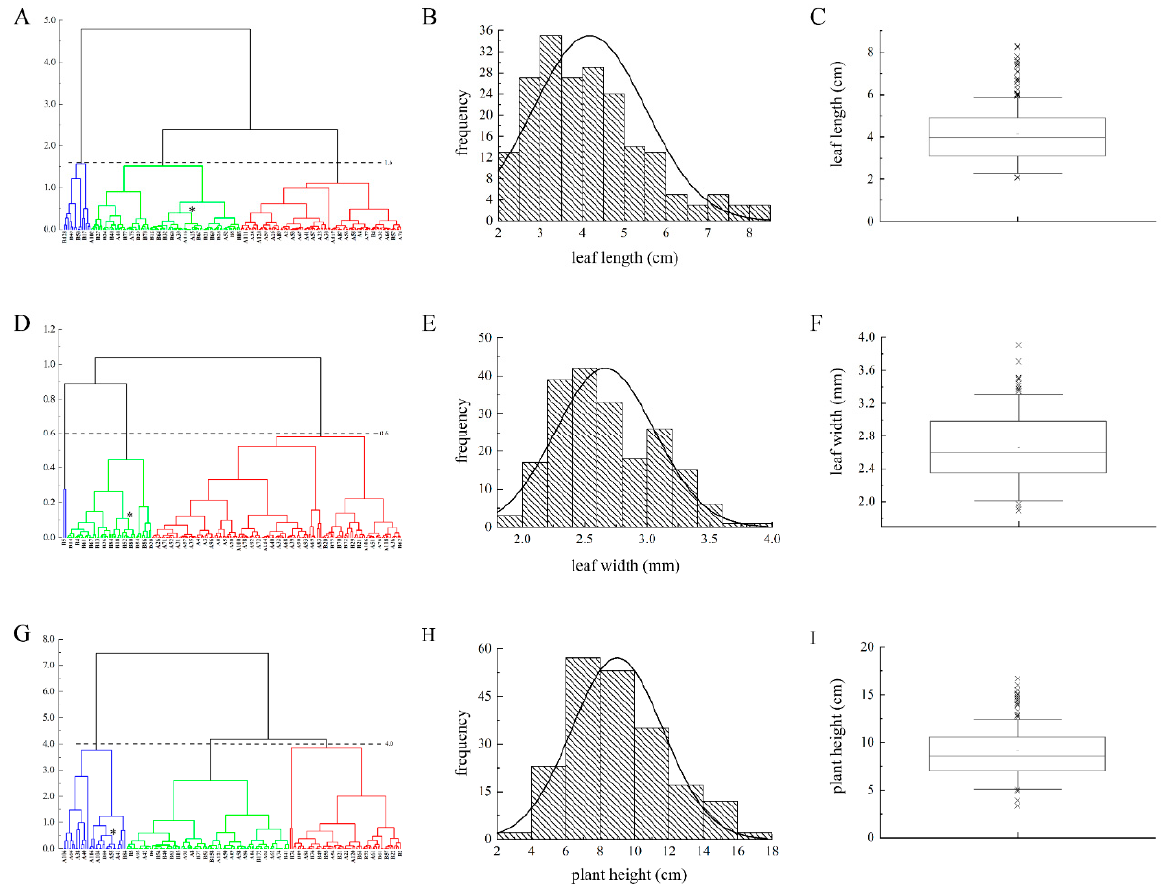
Figure 2. An analysis of leaf length, leaf width, and plant height of 201 materials. ( A ) The dendrogram of leaf length; ( B ) the frequency distribution histogram of leaf length; ( C ) the box plot of leaf length; ( D ) the dendrogram of leaf width; ( E ) the frequency distribution histogram of leaf width; ( F ) the box plot of leaf width; ( G ) the dendrogram of plant height; ( H ) the frequency distribution histogram of plant height; ( I ) the box plot of plant height; * indicates that WT is in this subtree; the overlapped labels are hidden in dendrogram; × indicates outliers.